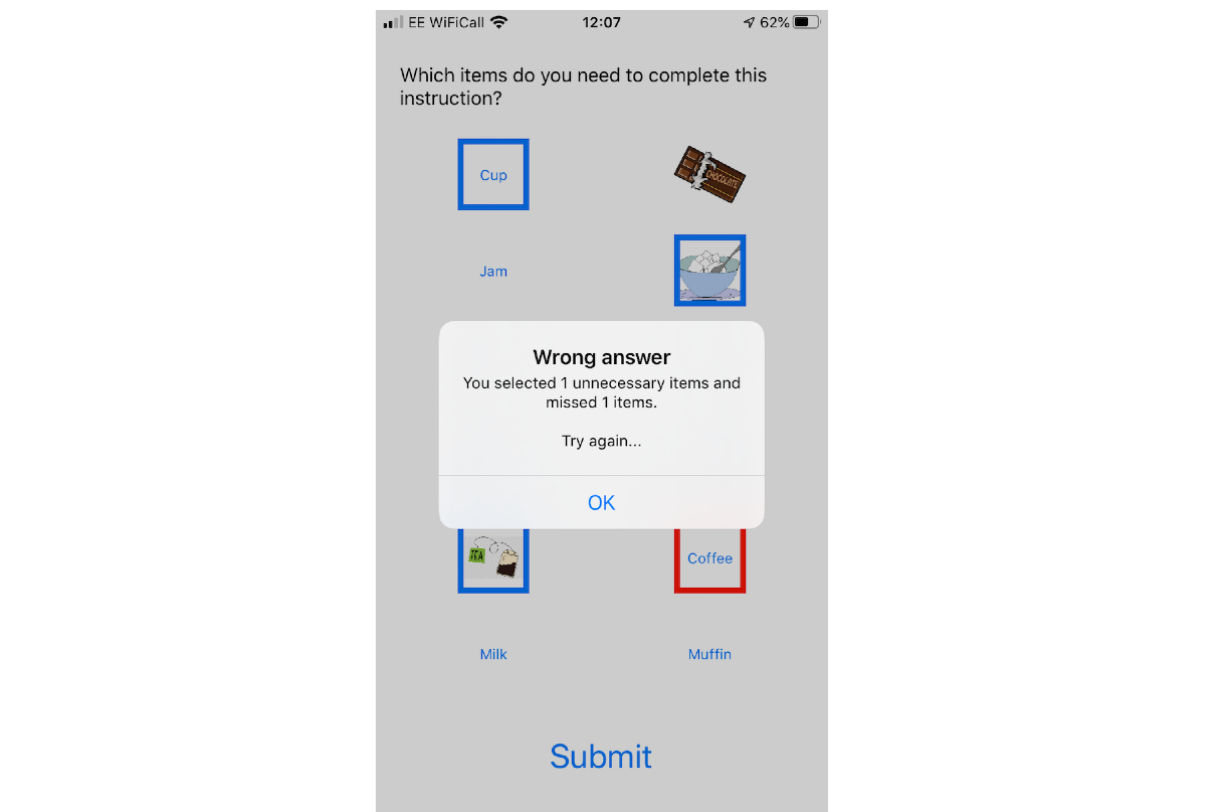
Figure 3. Example of incorrect answers